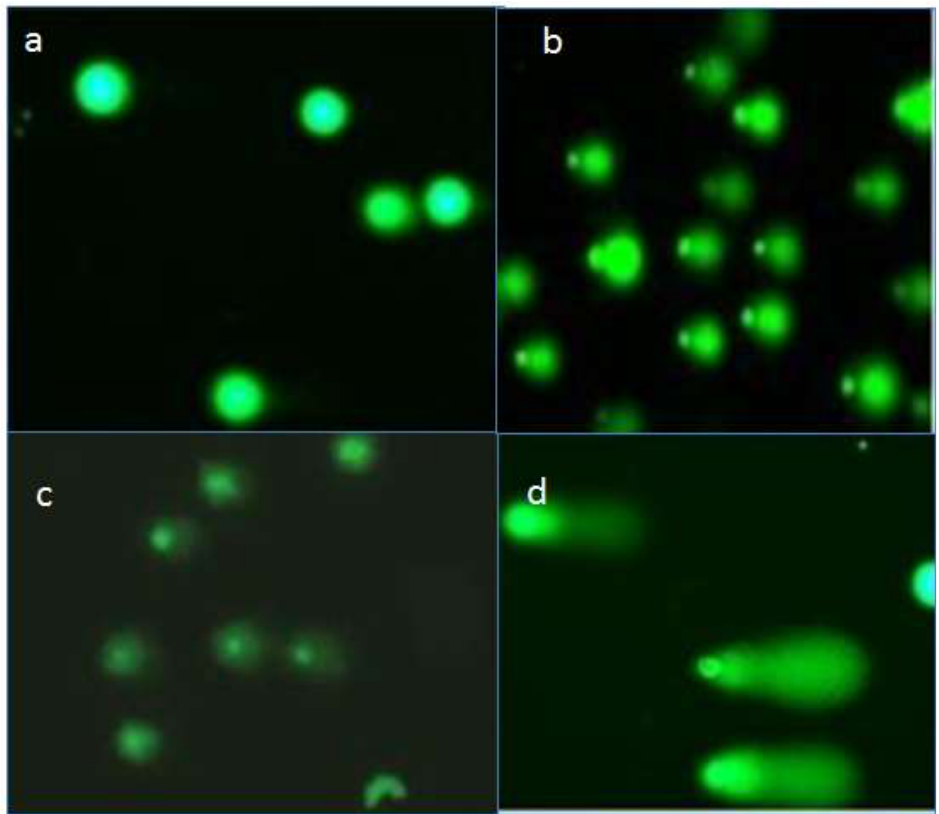
Figure 7. Images of EtBr-stained DNA migration towards anode. Damaged DNA from L. donovani was differentiated via alkaline comet assay: ( a ) normal DNA (untreated control) and DNA from samples treated with ( b ) quercetin, ( c ) gallic acid, and ( d ) rutin at (500 µg/mL) after 72 h of incubation.